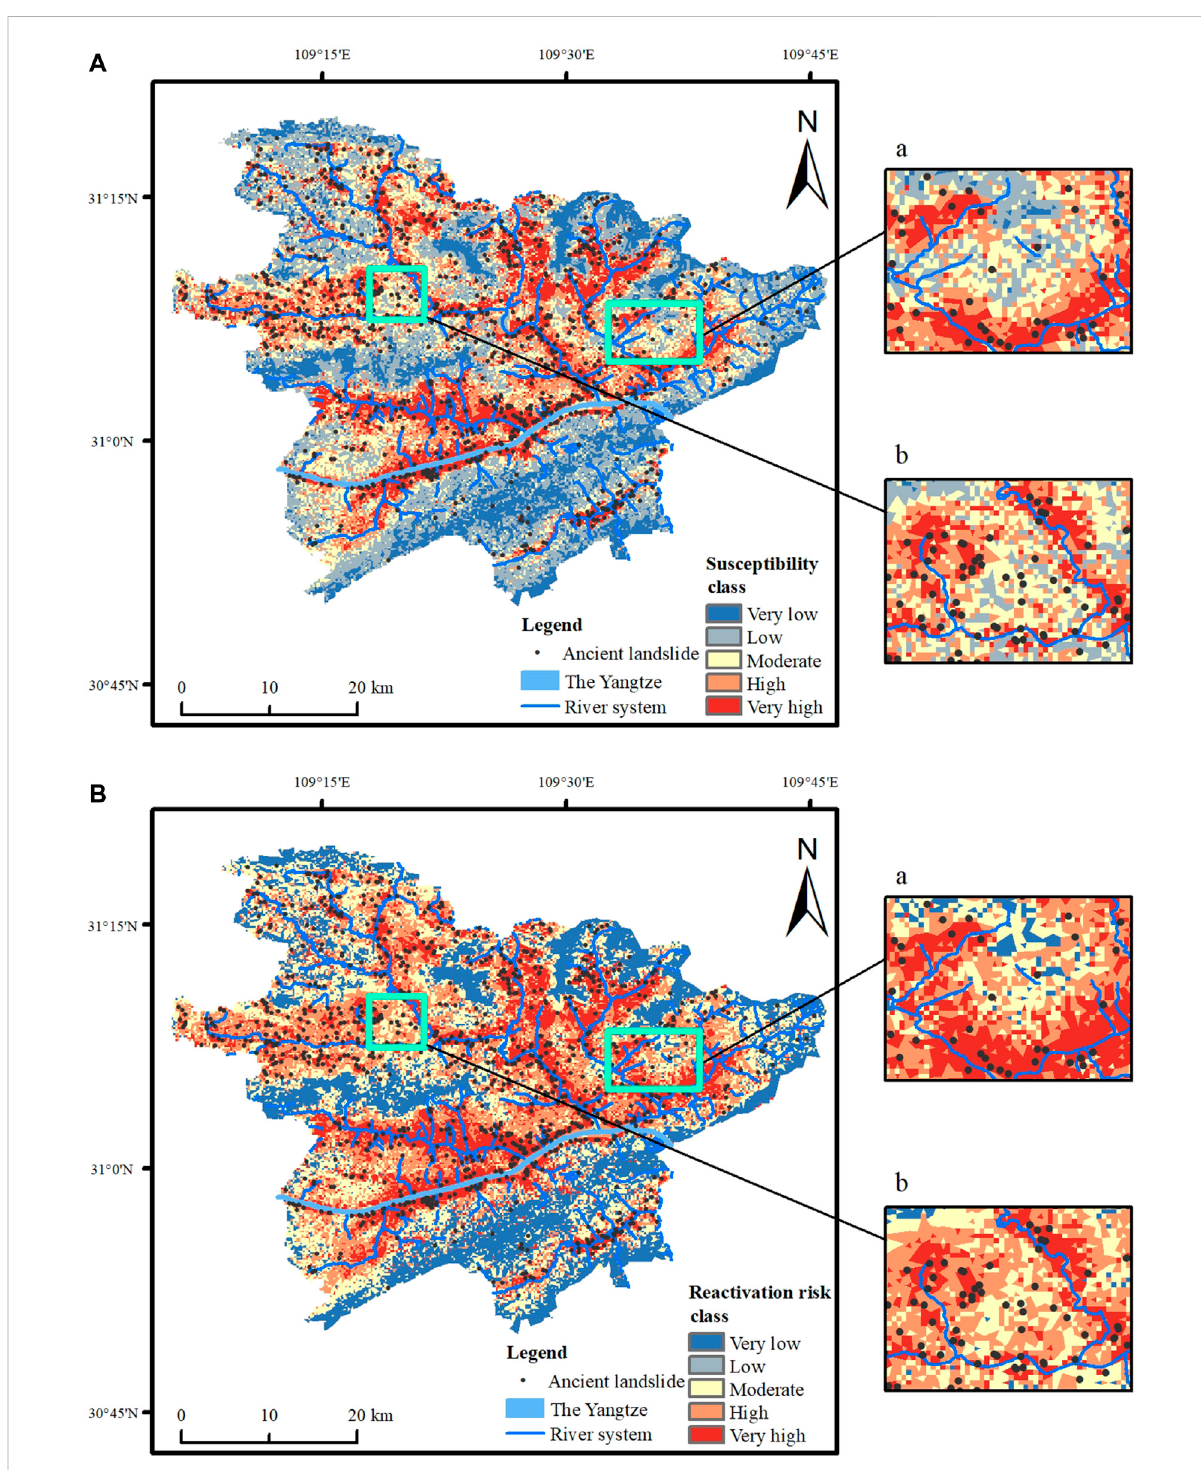
FIGURE 9 Comparative maps of typical areas at different scales. (A) Long-time scale landslide susceptibility map (B) Cross-time scale landslide risk